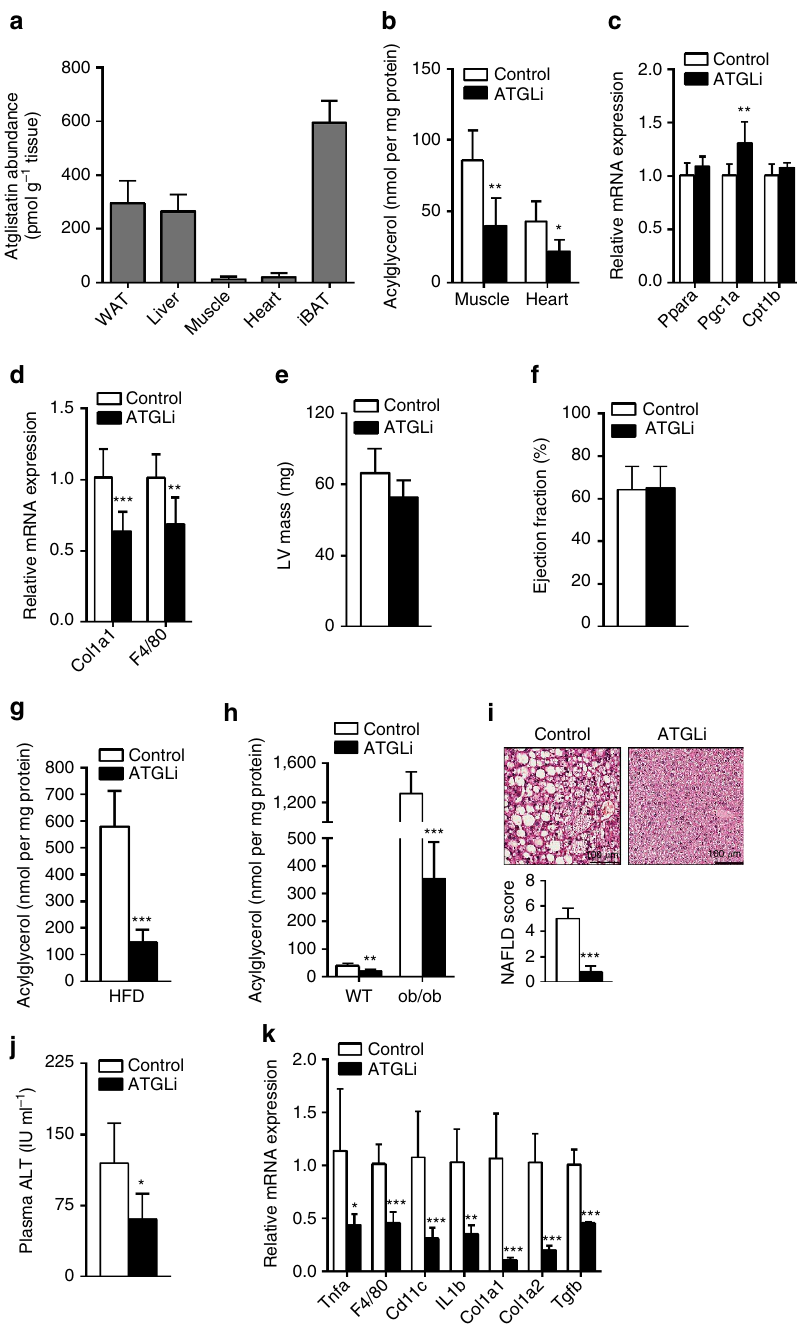
Figure 5 | Atglistatin protects from HFD-induced NAFLD. Six weeks old male C57Bl6J mice were fed a HFD (45kJ% fat; 22.1kJg (cid:2) 1 ) for 50 days. Thereafter, mice were fed a HFD in the presence and absence of Atglistatin for 140 days. ( a ) Atglistatin abundance was determined in extracts of adipose- and non-adipose tissues using liquid chromatography–mass spectrometry analysis ( n ¼ 6 per group). ( b , g , h ) Total lipids were extracted and acylglycerol levels were determined in ( b ) m. quadriceps, and heart and ( g ) livers of wt mice fed a HFD or ( h ) in livers of ob/ob mice fed a chow diet in the presence or absence of Atglistatin ( n ¼ 6 per group). ( c ) mRNA expression of Ppar a , Cpt1b and Pgc-1 a was assessed in hearts of moderately fasted animals ( n ¼ 6 per group). ( d ) mRNA expression of inflammatory and fibrosis marker genes was assessed in hearts of re-fed animals ( n ¼ 9 per group). ( e ) Left ventricular mass and ( f ) ejection fraction of hearts from control and ATGLi animals was assessed by MRI after 5 weeks of diet intervention ( n ¼ 5 per group). ( i ) Haematoxylin–eosin sections of liver tissues were categorized according to lipid droplet abundance, inflammatory foci and cell ballooning. NAFLD score is the sum of the steatosis, inflammation and ballooning score. ( j ) ALTenzyme activity was measured in fresh isolated plasma using a commercial kit ( n ¼ 9 per group). ( k ) mRNA expression of inflammatory and fibrosis marker genes was assessed in livers of re-fed animals ( n ¼ 7 per group). Data represent mean þ s.d. Statistical significance between control and ATGLi was determined by two-tailed Student’s t -test; * P o 0.05, ** P o 0.01 and *** P o